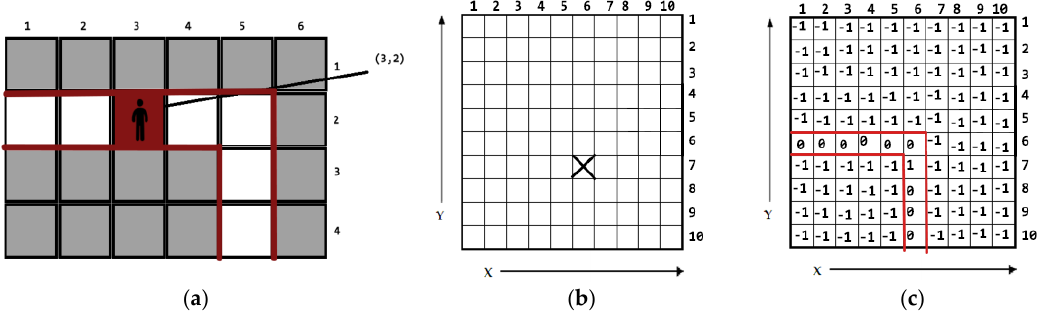
Figure 9. Indoor tiles map: ( a ) Example of current user position on the assistive tactile path calculated in real time; ( b ) Example room tile map with user position at point (6, 7); ( c ) Room tile map illustrating the user position on the highlighted assistive tactile navigation path.